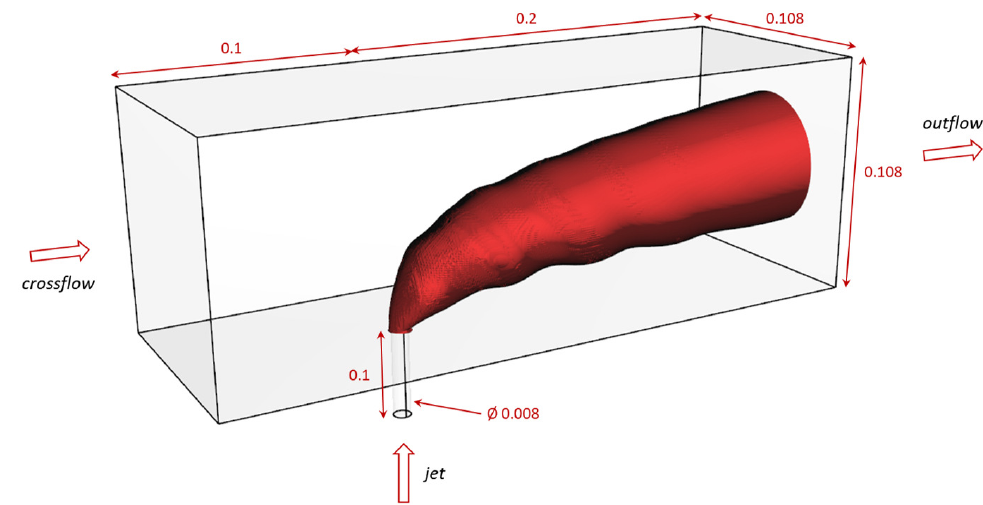
Figure 1. Computational domain and relevant dimensions in